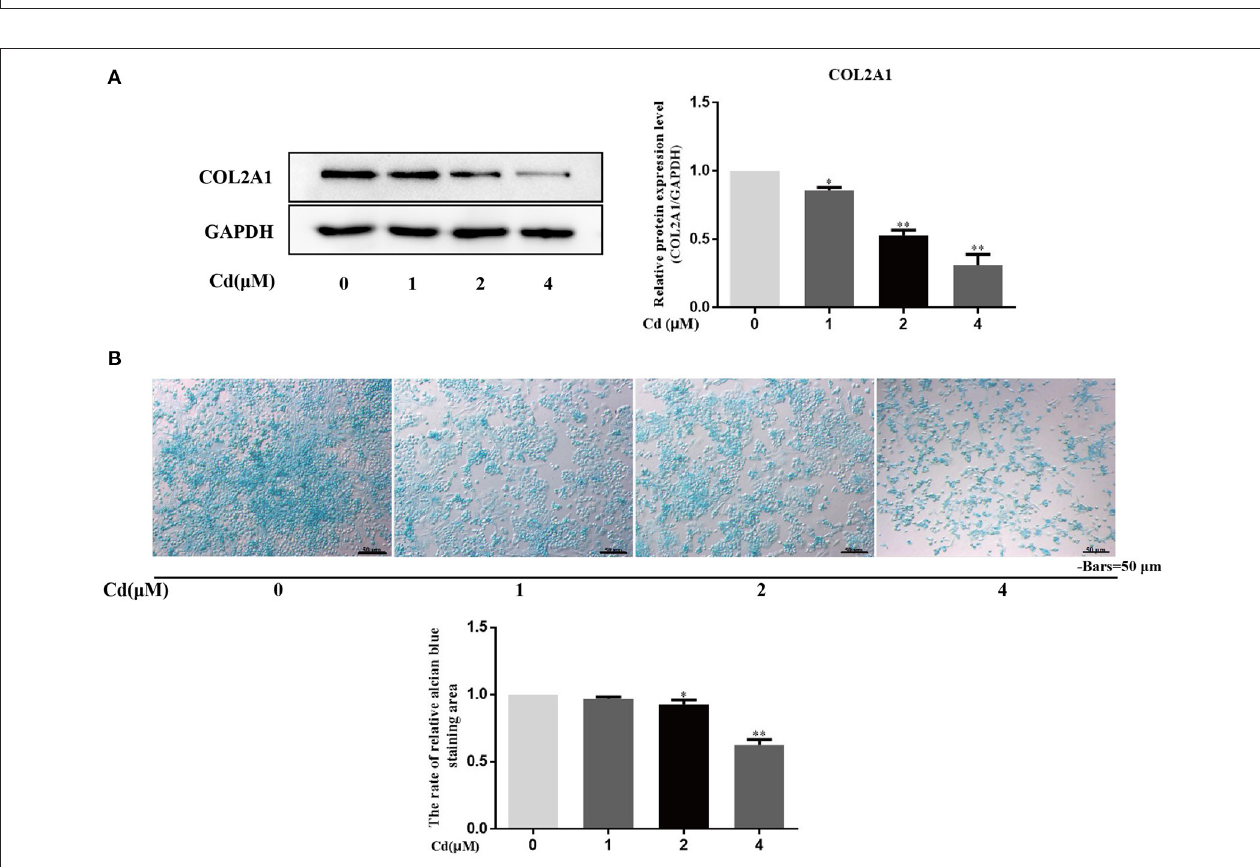
FIGURE 4 | Cd inhibited the expression of COL2A1 and acid mucopolysaccharide in chondrocytes. (A) Western blot analysis detecting the relative expression of COL2A1 protein after chondrocytes were treated with Cd for 3 days showed that, compared with the control group, the expression of COL2A1 protein was reduced after > 1 µ M Cd treatment. (B) Alcian blue staining of primary chondrocytes treated with Cd for 3 days showed that > 2 µ M Cd significantly reduced the acid mucopolysaccharide in chondrocytes compared with the control group. All data are represented as mean ± standard deviation; n = 3; * P < 0.05 and ** P < 0.01, significant difference relative to the day 0